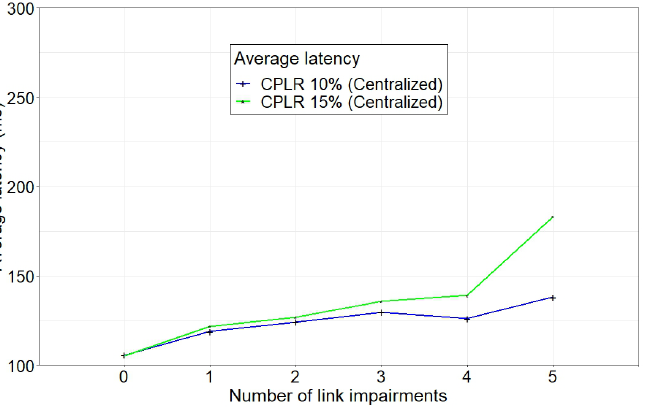
Figure 9. Average latency behavior of centralized network operation during data plane link failures for various times under unreliable control plane conditions in a 9-node grid network.